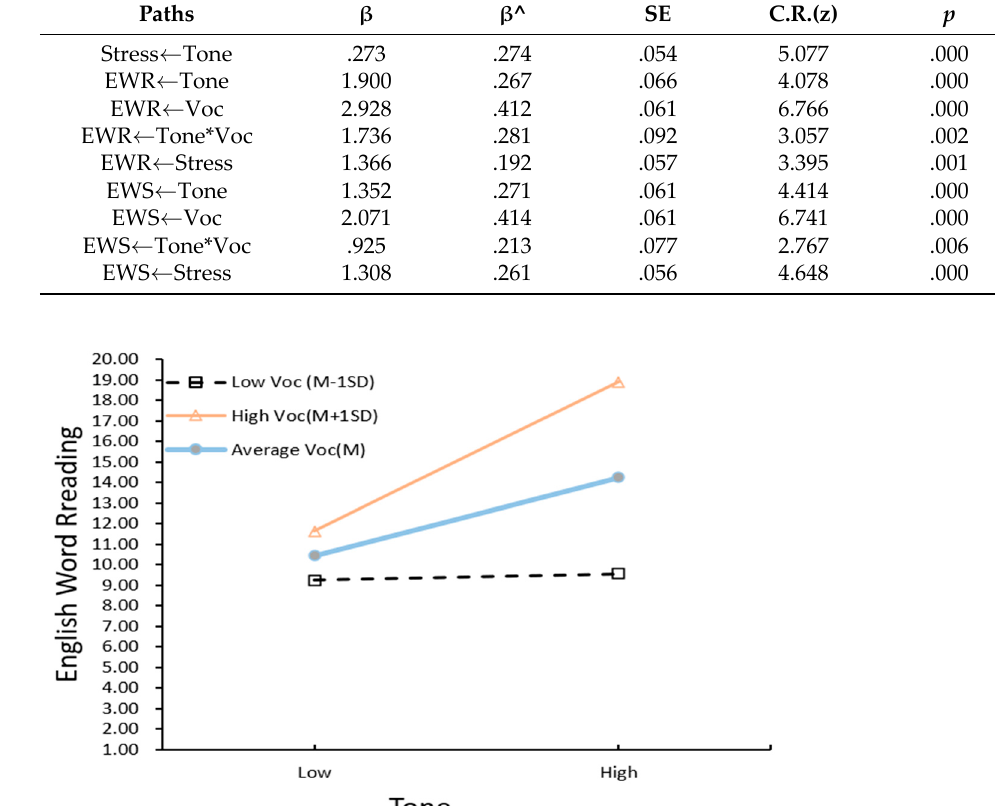
Figure 4. The respecified moderated mediation model of tone, stress, vocabulary, and English word-